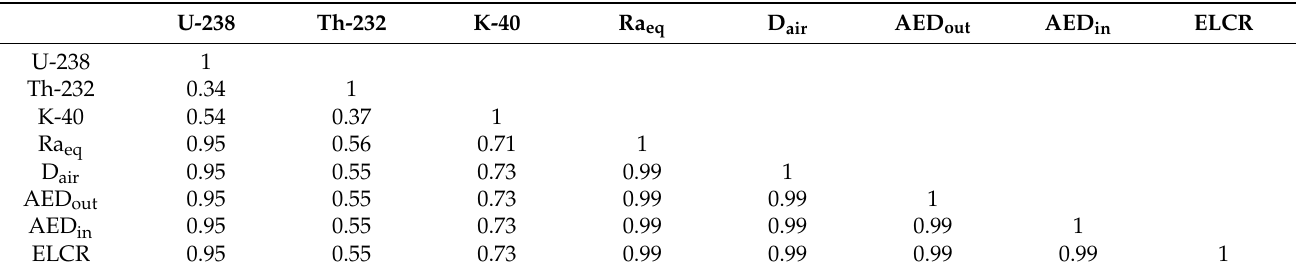
Table 8. Pearson correlation matrix for variables.